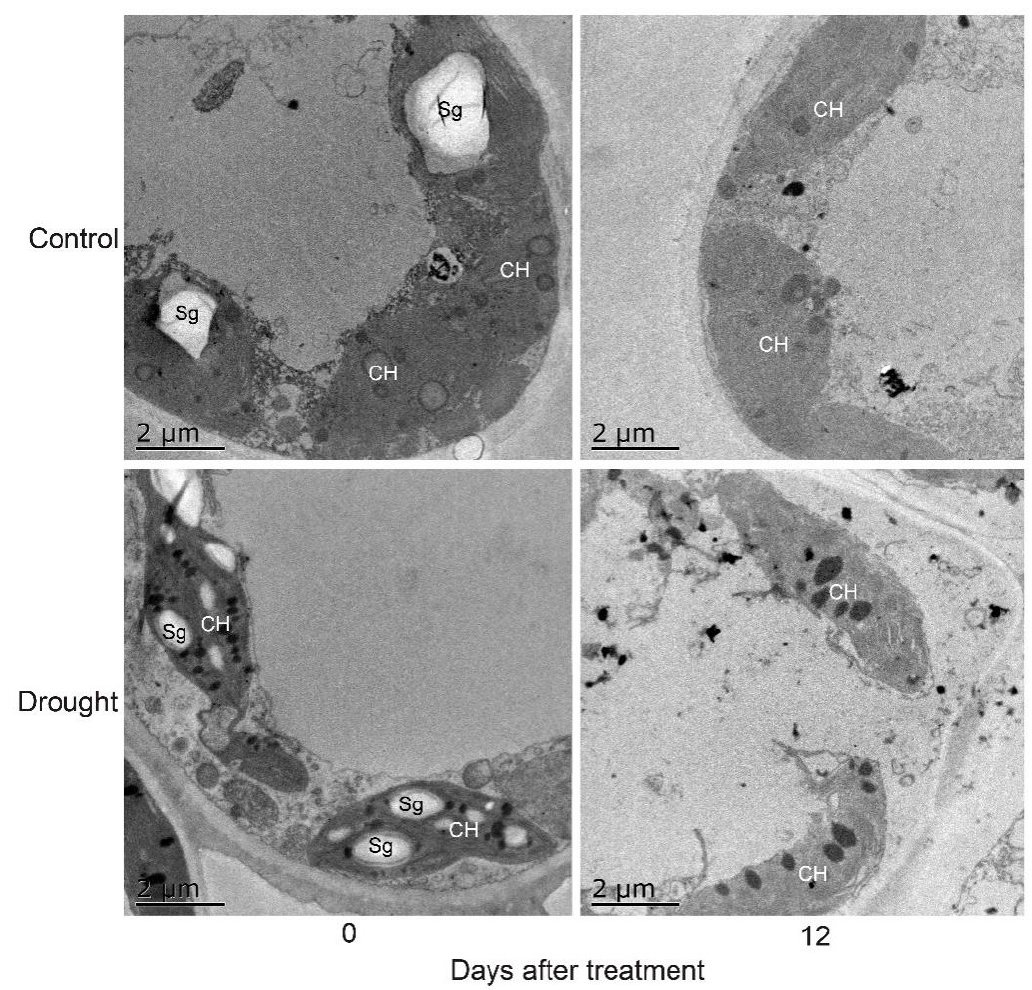
Figure 5. Mesophyll cell changes of drought-treated P. ostii and the control. CH, chloroplast; Sg, starch grains.